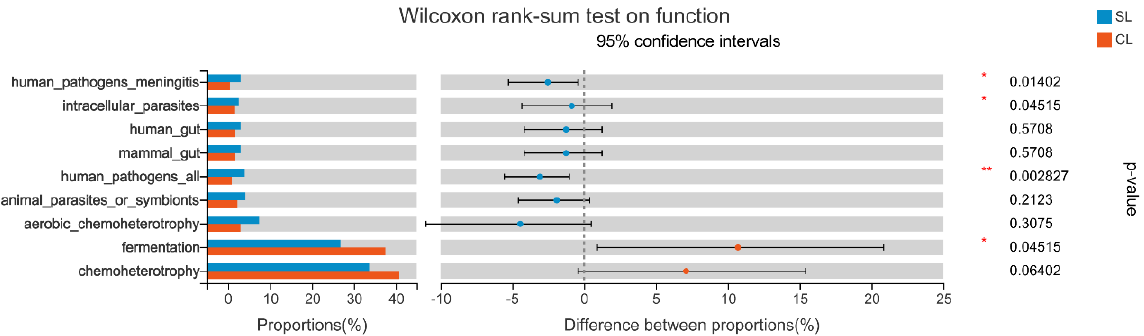
Figure 9. Difference test between functional groups of intestinal microbiota of SL and CL Anser fabalis. The P value: * p < 0.05; ** p < 0.01.